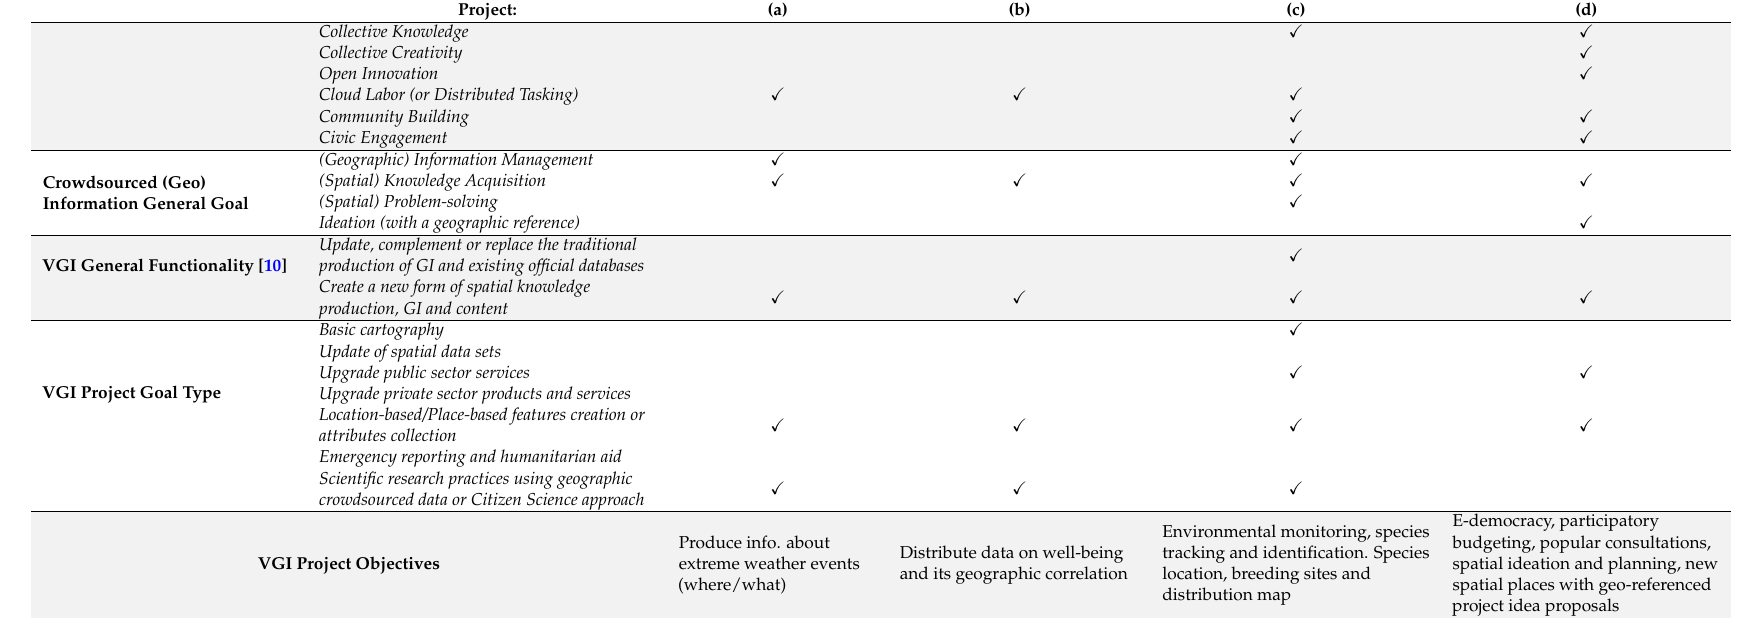
Table 4. VGI Project Goal